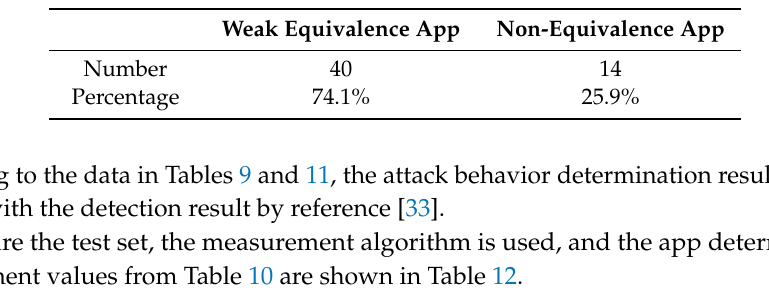
Table 11. Decision result of the equivalence